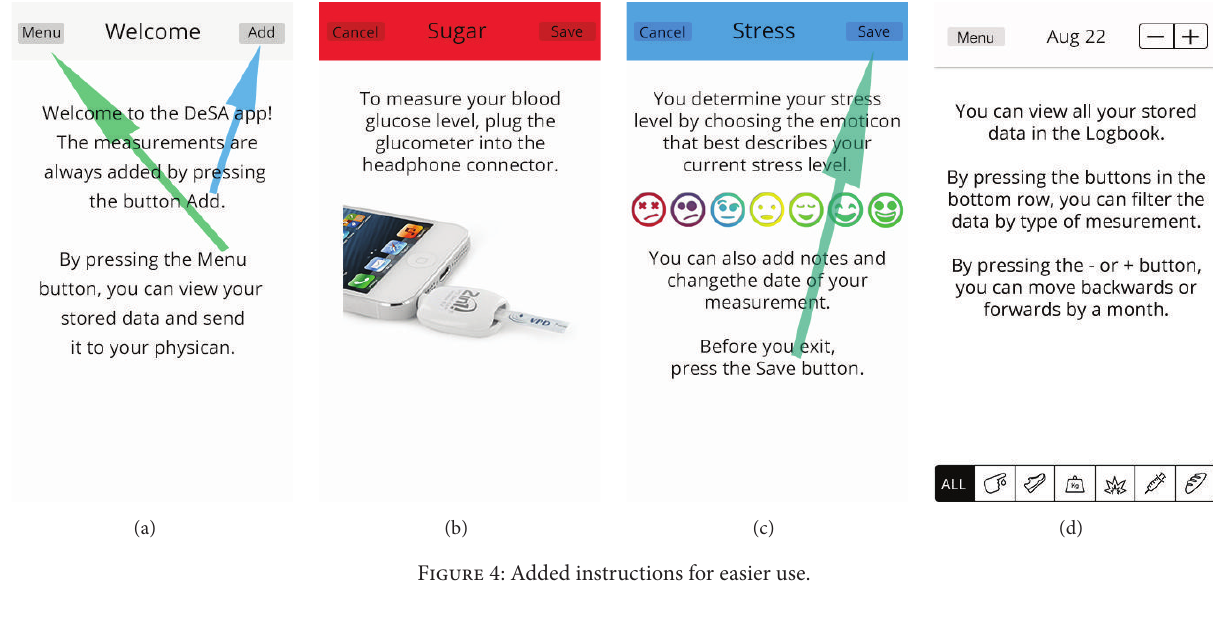
Figure 4: Added instructions for easier use.